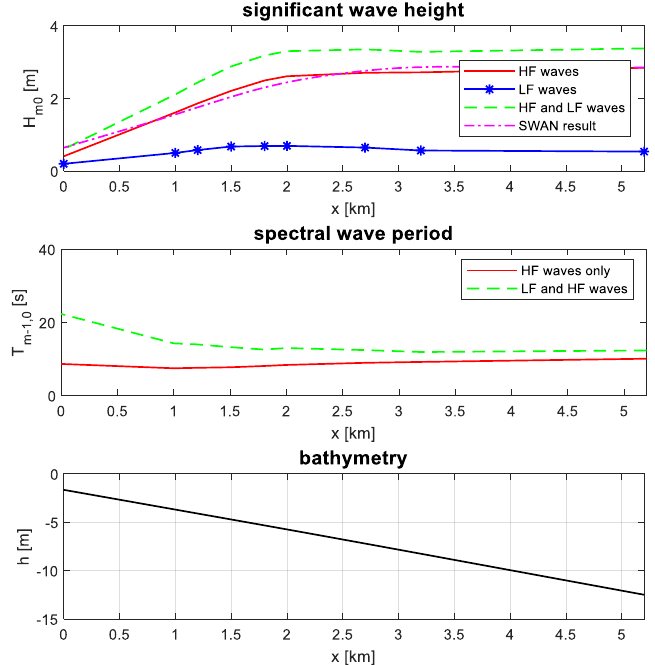
Figure 6. SWAN and SWASH results for 1:500 slope.